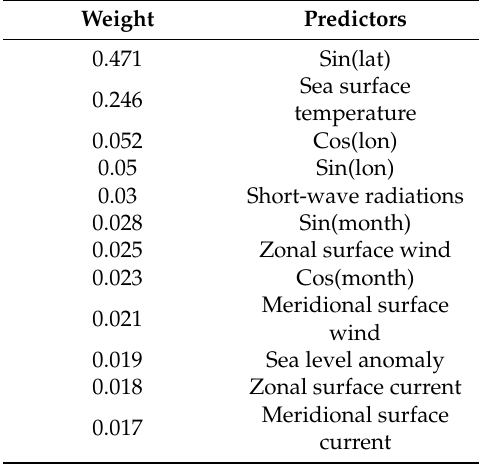
Table 2. Multi-layer perceptron (MLP) predictor’s relative